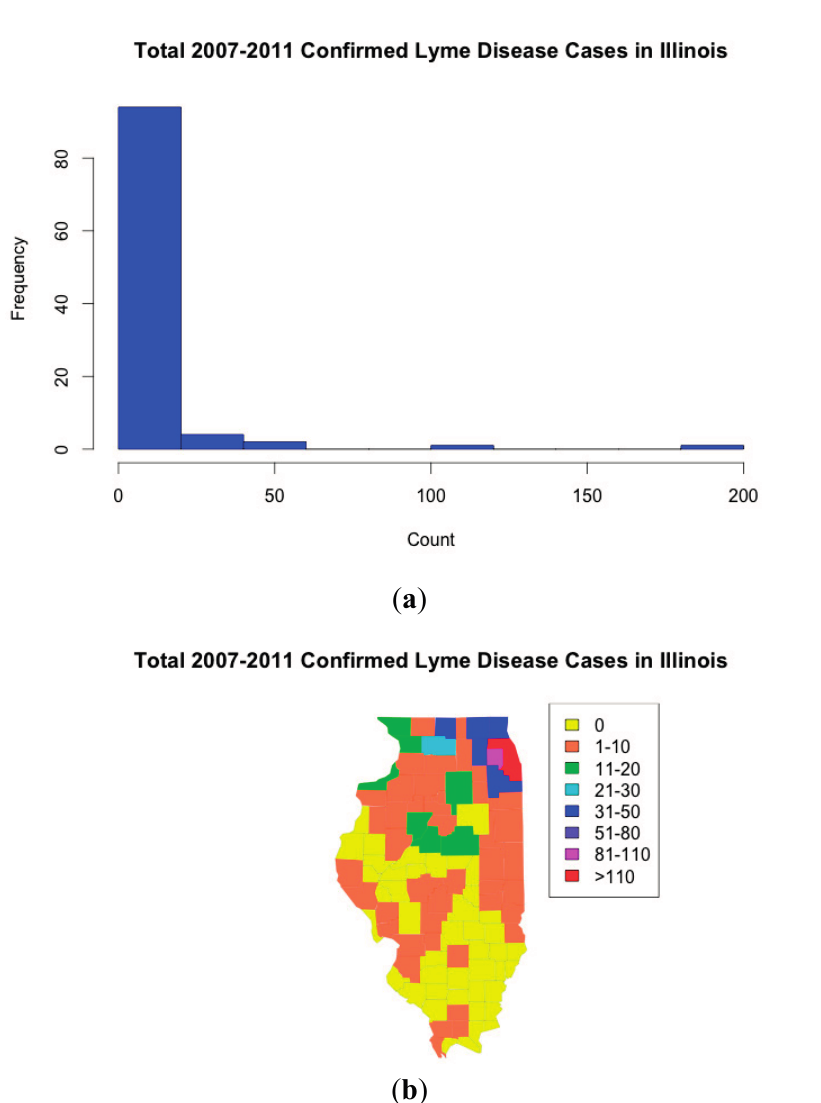
Figure 1. Histogram ( a ) and map ( b ) of the total number of confirmed cases of Lyme disease in Illinois by county for the 5–year interval